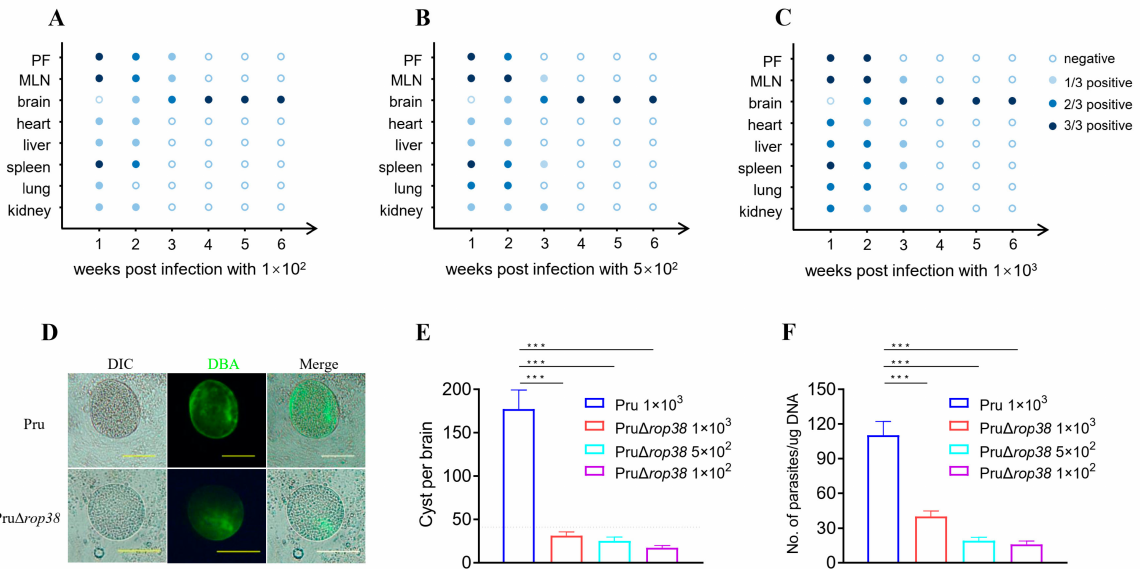
Figure 2. Dynamic distribution and effect on brain parasite burden of Pru ∆ rop38 in mice. Amplifi- cation results of T. gondii -specific genes from organs and tissues in mice. Injections of ( A ) 1 × 10 2 , ( B ) 5 × 10 2 , and ( C ) 1 × 10 3 Pru ∆ rop38 tachyzoites, respectively. ( D ) Cyst counts were performed on brain homogenates by DBA-FITC staining, brain cyst from mice injected with Pru ∆ rop38